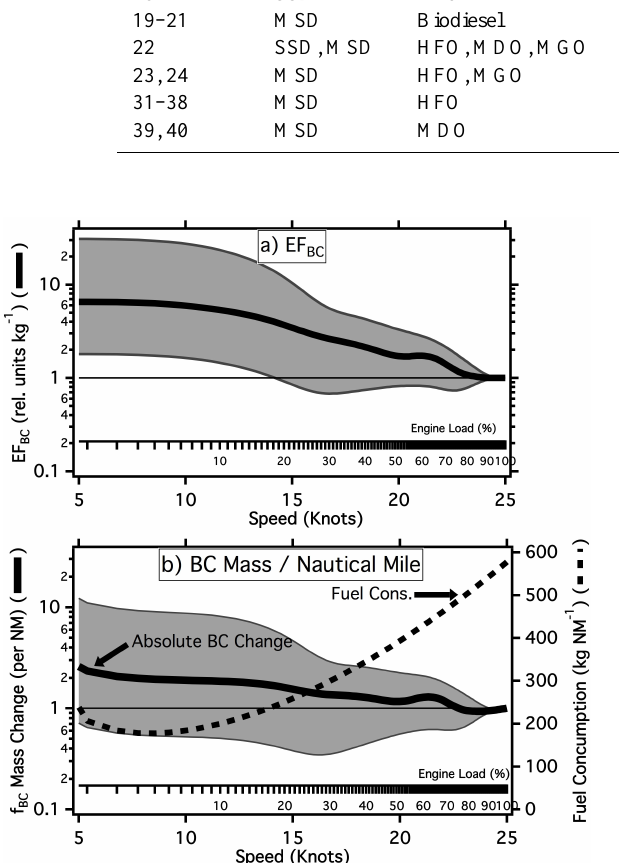
Fig. 3. (a) Average EF BC change with ship speed and engine load (with 10th and 90th percentiles) and (b) the potential absolute changes in BC emissions with ship speed and engine load (with 10th and 90th percentiles). EF BC data from (a) combined with fuel consumption data from (b) (circle points) to produce data in (b) . All but F Cons are normalized to 1 at 100% load.